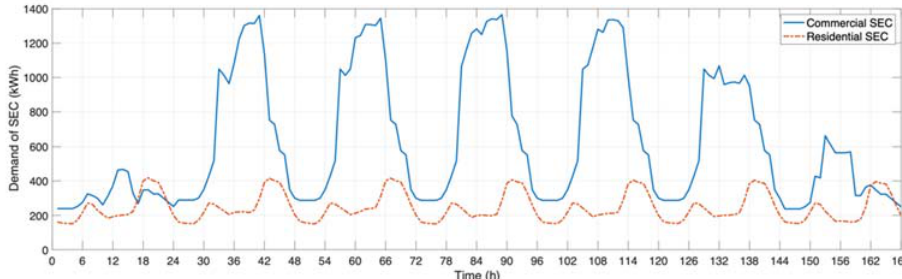
Figure 3. Typical demand of a commercial SEC (blue line) and a residential SEC (dashed red line) for a week.